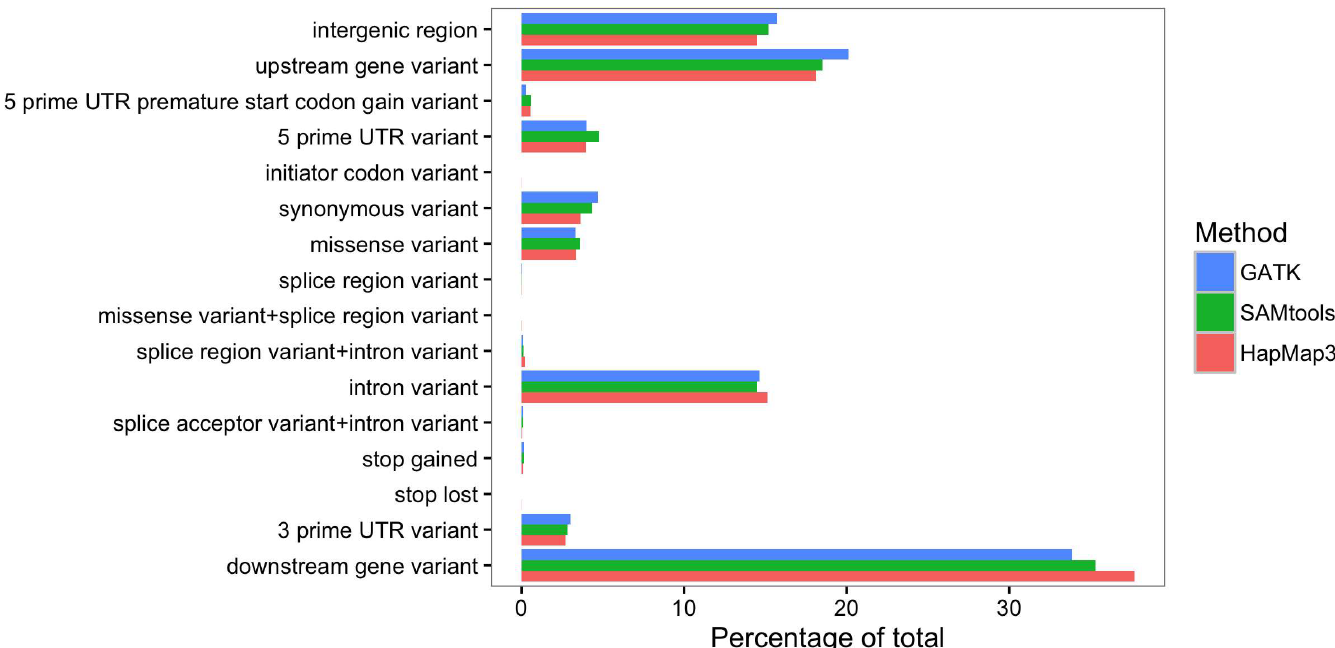
Fig 4. Variant classification by method. The distributionof variants classified accordingto genomicregionor type of variation. GATK and SAMtools variant calls were comparedto the HapMap3variants in the regionof interest.